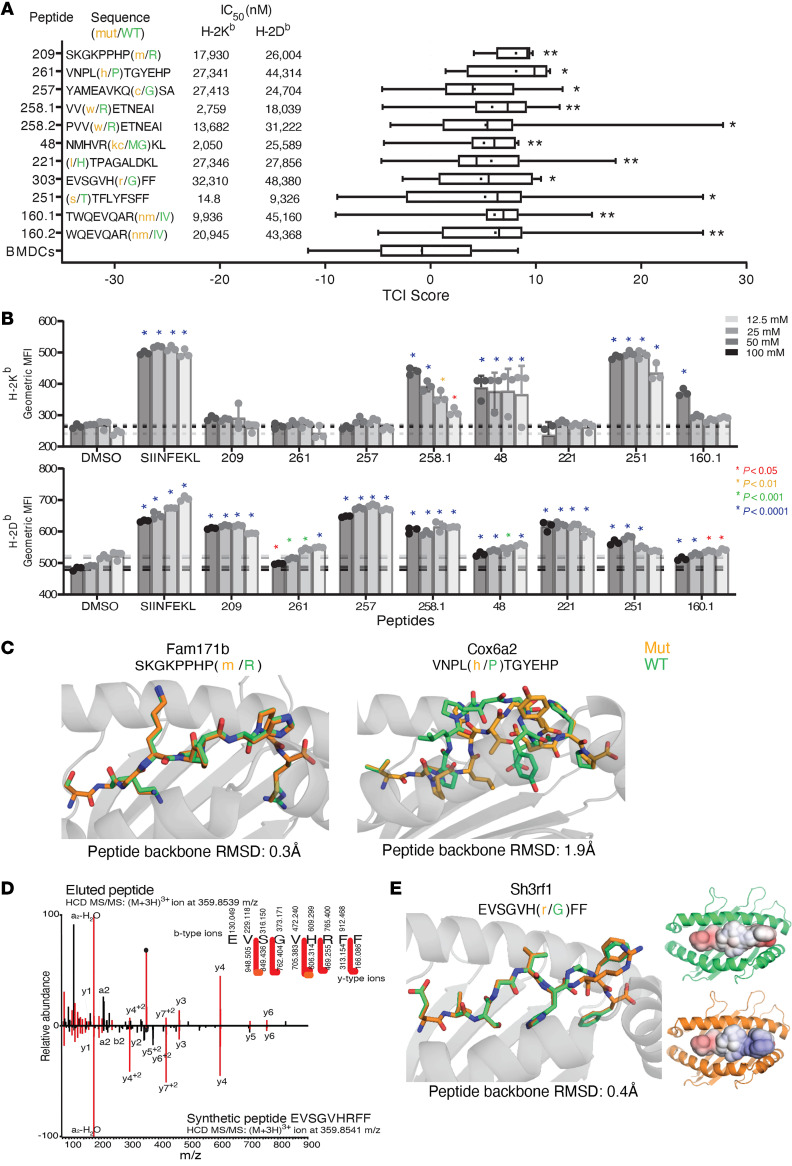
Definition of precise peptides for FAM171b and COX6a2 and their interaction with cognate MHC I alleles.(A) Sequences and binding affinities for Kb and Db of the putative precise peptides of the 9 TRMNs (left); TCI scores of mice immunized with precise TRMN peptides, n = 15 mice/group (right). *P < 0.05, **P < 0.01 by Student’s t test. (B) Geometric MFIs of Kb (top) and Db (bottom) of RMA-S cells pulsed with precise TRMN peptides. Data represent mean of triplicate values ± SD. *P < 0.05 by 2-way ANOVA. Each peptide was tested at least 2 times. (C) Structural models of binding of Kb with precise peptides of WT and mutant FAM171b, COX6a2. The WT is shown in green and the mutant in orange, with the MHC binding groove in gray. (D) MS/MS mirror plot displaying similarity of overall fragment ion coverage and relative abundances of identified fragment ions between a single-scan pulsed BMDC MS/MS (top pane) matched to sequence EVSGVHRFF and the single-scan MS/MS of the corresponding synthetic peptide (bottom pane). Fragment ions and neutral losses are labeled in both spectra, shared ions are shaded maroon, and singly charged (red arrows) and doubly charged ions (orange arrows) are annotated as observed for the pulsed BMDC peptide in the fragment ion coverage map. Ions represented by “•” denote those that fall within the prescribed isolation window. (E) Left: structural model of SH3RF1 bound to Kb. The color scheme is as in C. APBS electrostatic surface potentials of mutant Sh3rf1 (top right) and WT Sh3rf1 (bottom right). Surface potentials are on a scale of –4.000 (blue) to +4.000 (red) kBTec–1, or approximately 26.7 mV per 1.000 at 310 K. Box-and-whisker plots were generated as in Figure 1.